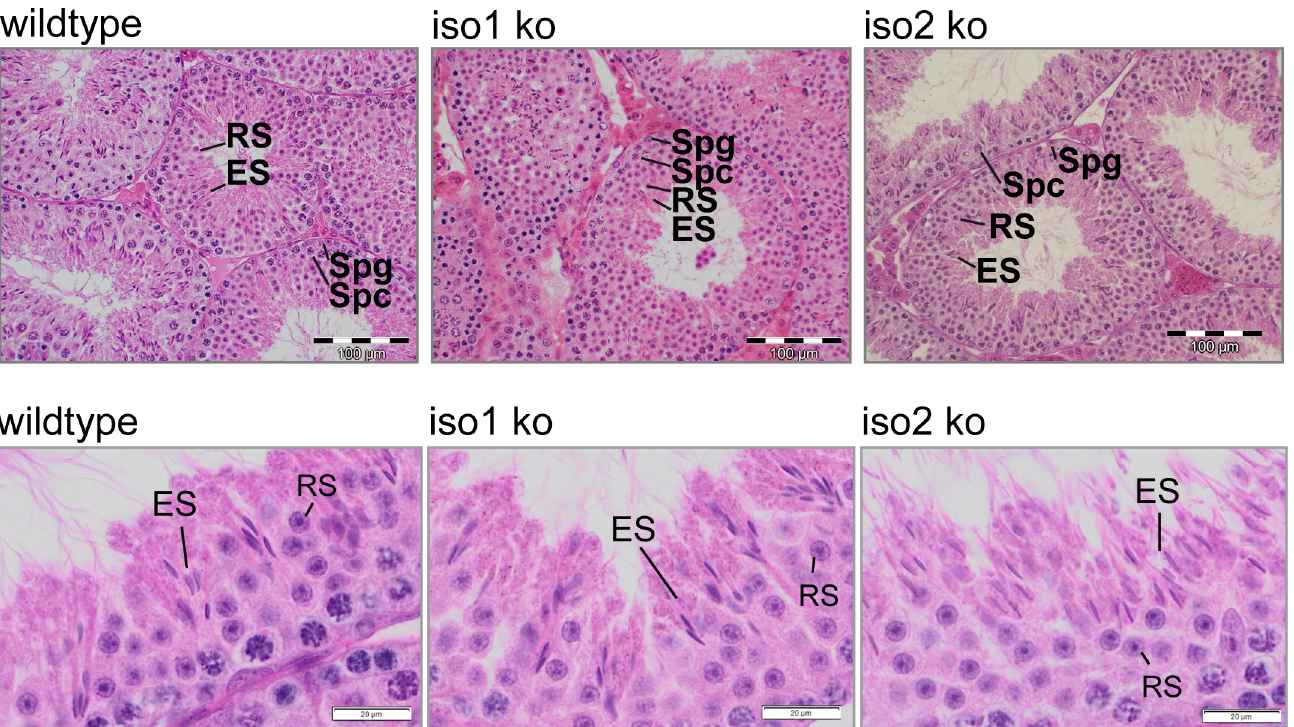
Fig 7. Unchanged histology in knockout testes. H&E stained testes from 3 months old iso1 ko and iso2 ko mice show normal sperm head morphology of stage 15 spermatids. (RS, round spermatids; ES, elongated spermatids). Scale bar = 20 μ m.